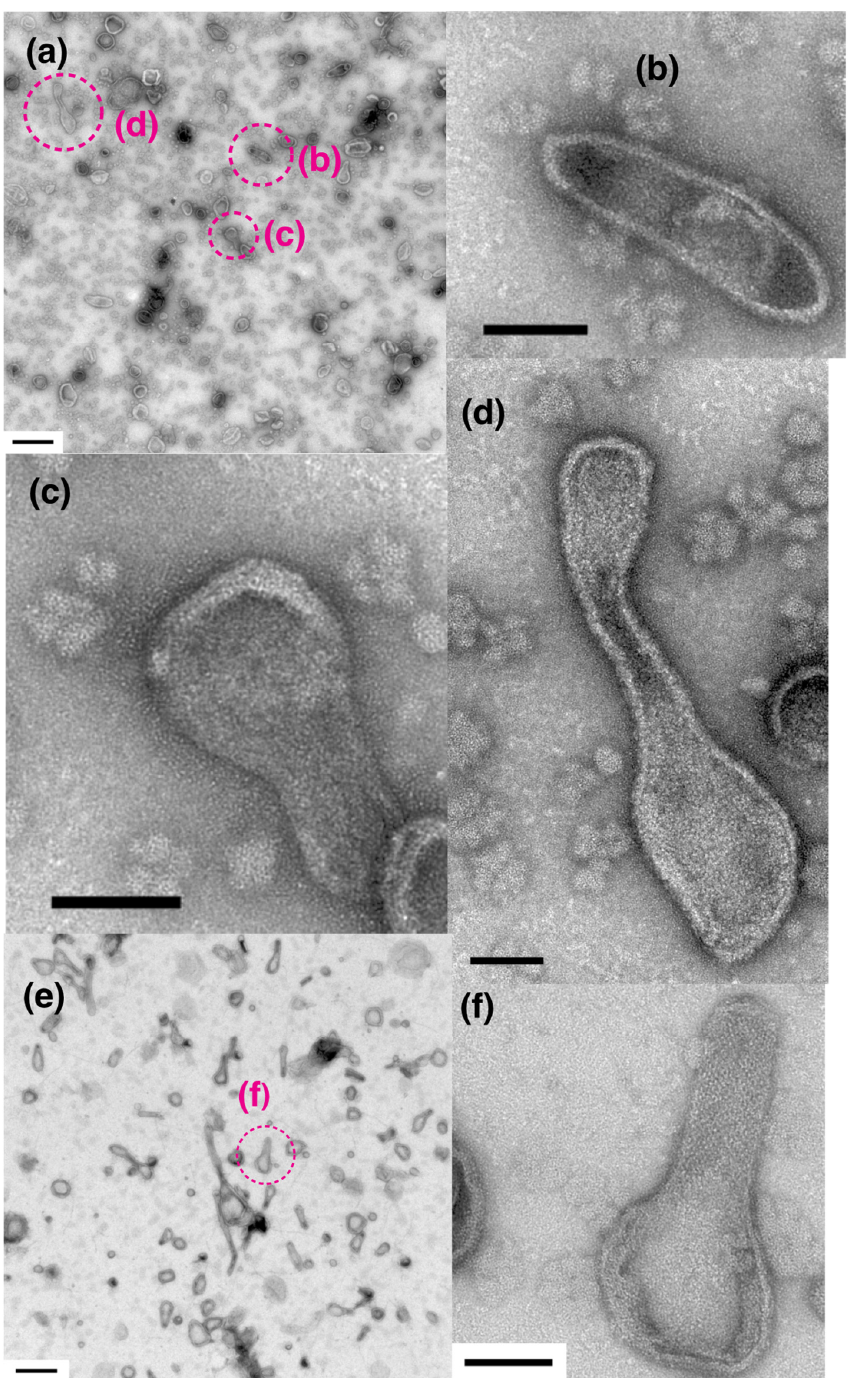
Figure 10. Effect of thapsigargin (TG) on the crystallization of 40 Å ATPase particles of SR vesicles in the presence of ATP. ( a – d ) SR vesicles with TG (2 µM) and dimethylsulfoxide (DMSO) (0.12% ( v / v )). ( b – d ) are higher magnification images of the dotted circles ( b – d ) in ( a ), respectively. ( e , f ) Vesicles treated with DMSO alone. ( f ) Higher magnification image of the dotted circle ( f ) in panel ( e ). In ( a – d ), TG was added to the reaction mixture at the ratio of 6.7 nmol/mg SR protein, assuming that 40–50% of the total protein present was Ca 2+ -ATPase [15]. The ratio of TG to the scallop Ca 2+ -ATPase protein (13.4–16.8 nmol TG/mg of the ATPase protein) was higher than that (10 mmol/mg Ca 2+ -ATPase protein of the rabbit SR) [23] required for the complete inhibition of the Ca 2+ -ATPase activity of the Ca 2+ -ATPase rich (~90%) rabbit SR. After the TG treatment, the SR was reacted with ATP for 1 min. Scale bar in panels ( a , e ): 0.5 µm. Scale bar in panels ( b – e ): 100 nm.